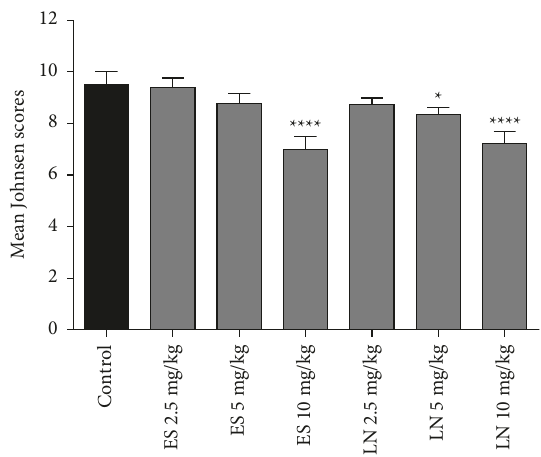
Figure 6: Histopathological scoring of testes from esomeprazole (ES) and lansoprazole (LN) treated rats. ∗ P < 0 . 05 and ∗∗∗∗ P < 0 . 0001 showed a significant difference from the normal control